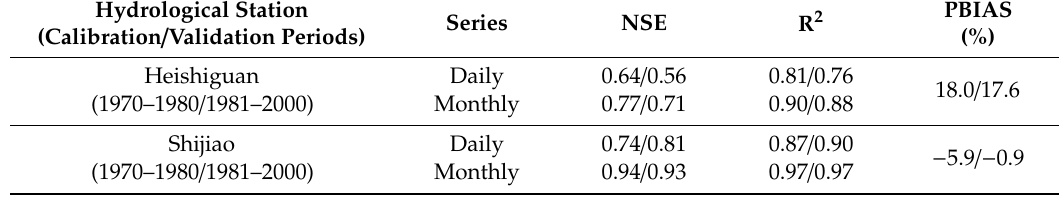
Table 2. Performance of the HBV-D model in daily runoff simulation.